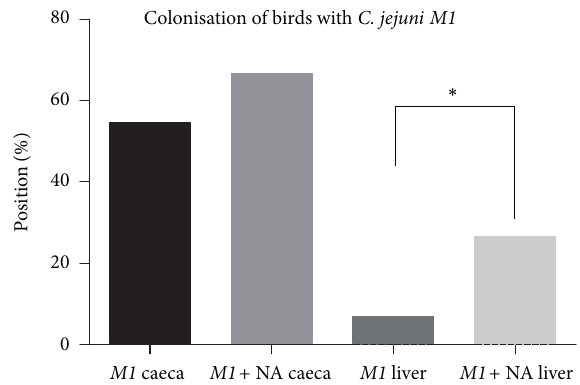
Figure 6: The percentage of caeca and livers positive when chickens were inoculated with C. jejuni or C. jejuni pretreated with NA. Notice that higher numbers of birds were positive in caecum in NA pretreated group than when infected with C. jejuni alone. Higher invasion into livers is seen in the NA-treated group only when infected with C. jejuni M1 . Results are from a single experiment consisting of ∼ 26 birds in a group. Statistical difference was assessed by a chi-square test and star represents significant 𝑃 < 0.05